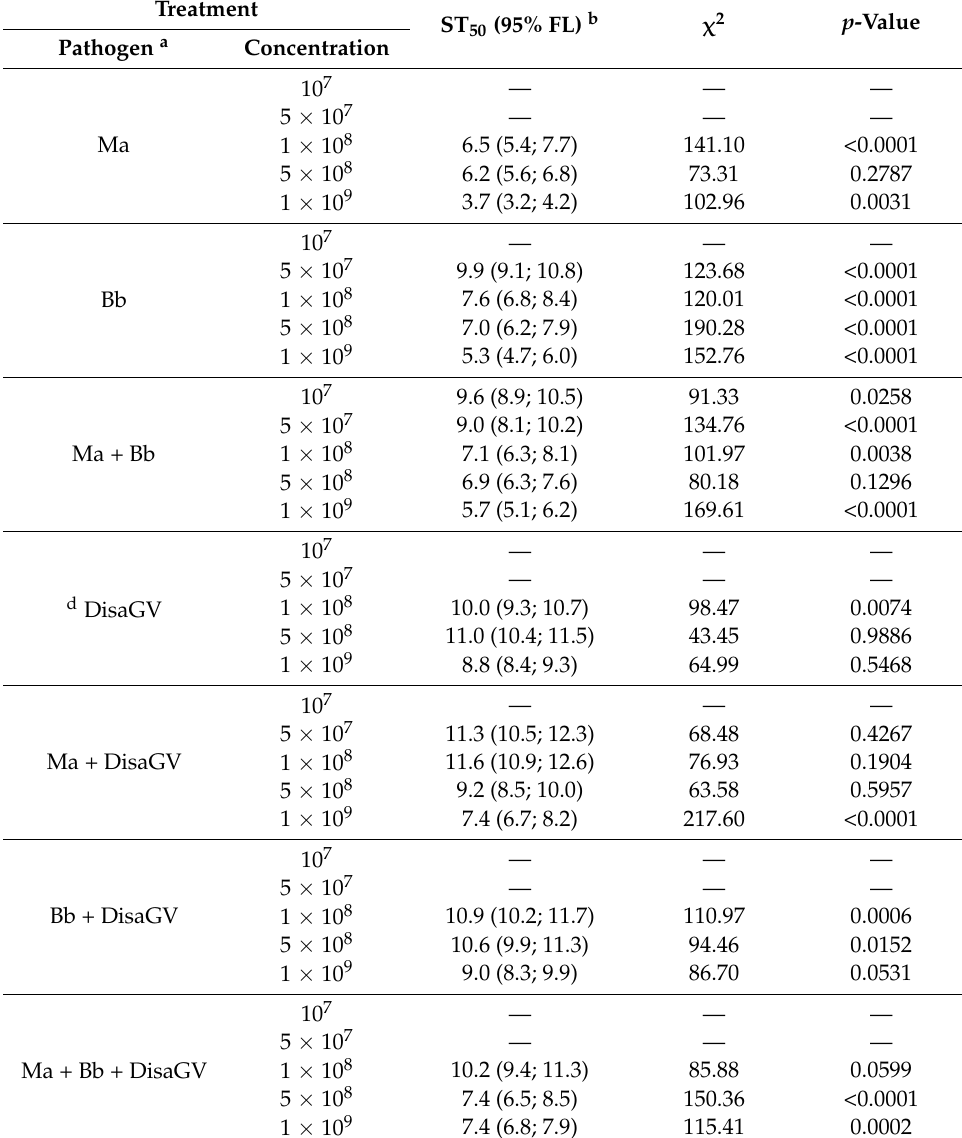
Table 2. Virulence of fungal and virus entomopathogens against the third instar larva of sugarcane borer, based on the median survival times (ST 50